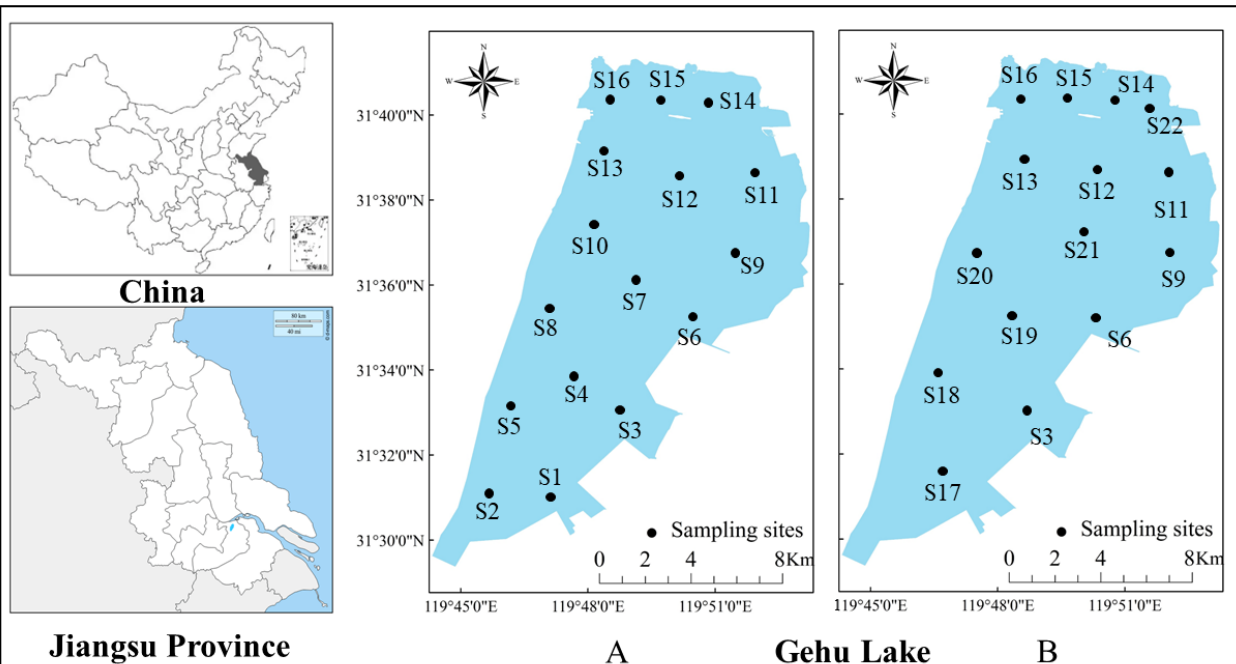
Figure 2. The geography of Gehu Lake in Jiangsu, China. Black circles indicate the sampling sites. The sampling sites during 2017–2018 ( A ) are from S1 to S16. The sampling sites during 2021–2022 ( B ) are S3, S6, S9, and S11–S22.